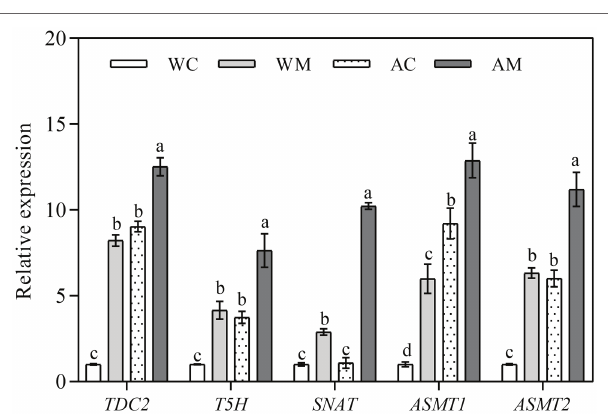
FIGURE 8 | Effect of exogenous MT on expression of melatonin synthesis genes. Data represent means ± SEs of three replicate samples. Different letters denote significant differences ( n = 3, and p < 0.05). WC, control; WM, control pretreated with MT; AC, alkaline stress; and AM, alkaline-stressed plants pretreated with